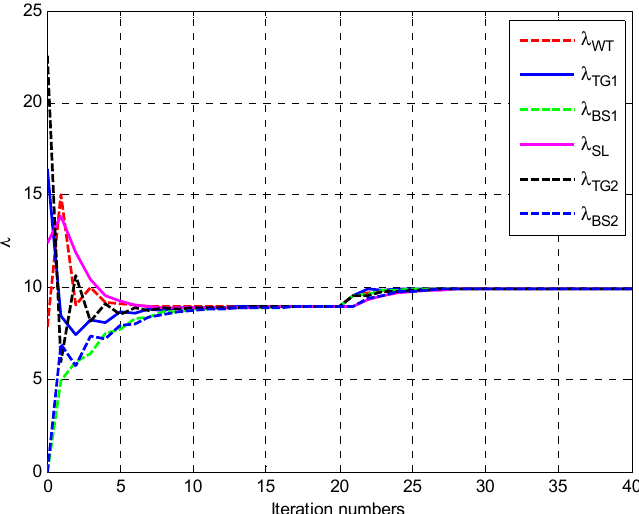
Figure 9. IC update of each node of the multi-period in the AC/DC hybrid microgrid.